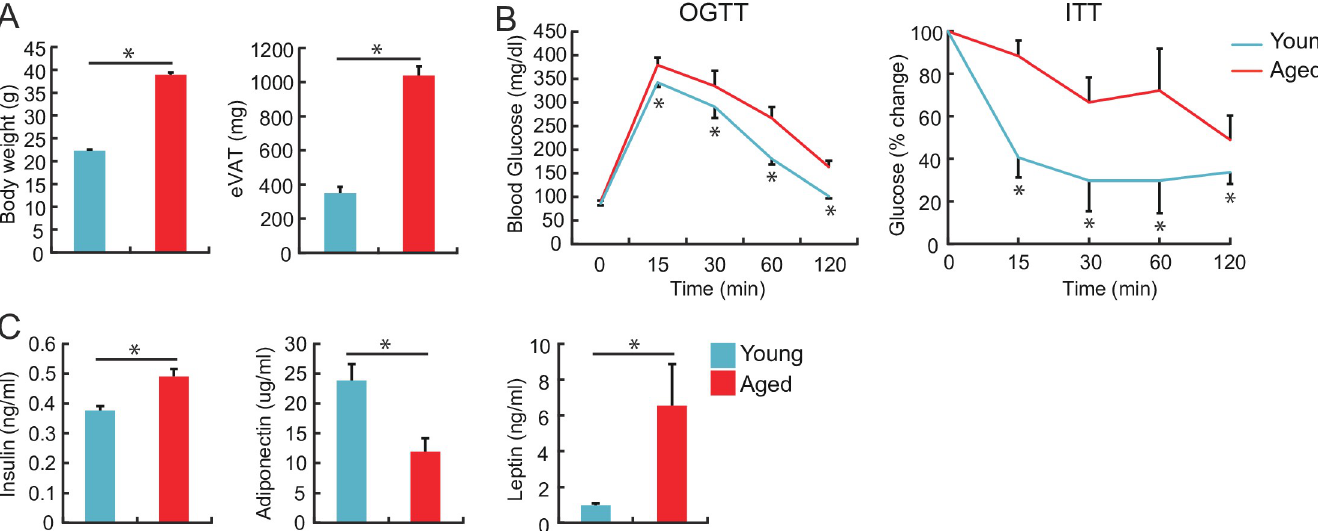
Fig 1. Increase in body and visceral adipose tissue (VAT) weight and the development of insulin resistance with advanced age. The body and epididymal VAT (eVAT) weights ( A ), results of oral glucose tolerance test (OGTT), and insulin tolerance test (ITT) ( B ) were compared between young and aged wild-type (WT) mice fed normal diet (ND) (10-week-old and 100-week-old, respectively) ( n = 6–8 animals in each group). ( C ) Serum levels of insulin, adiponectin, and leptin were compared between young and aged WT mice fed a normal diet (ND) (10-week-old and 100-week-old, respectively) (n = 6–8 animals in each group). � P < 0.05; NS: not significant. Data are represented as the mean ±